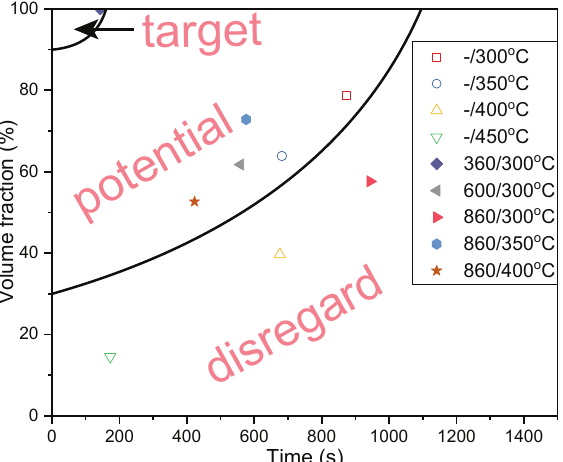
Figure 10. Volume fraction of transformed bainite versus PTTR (peak time of transformation